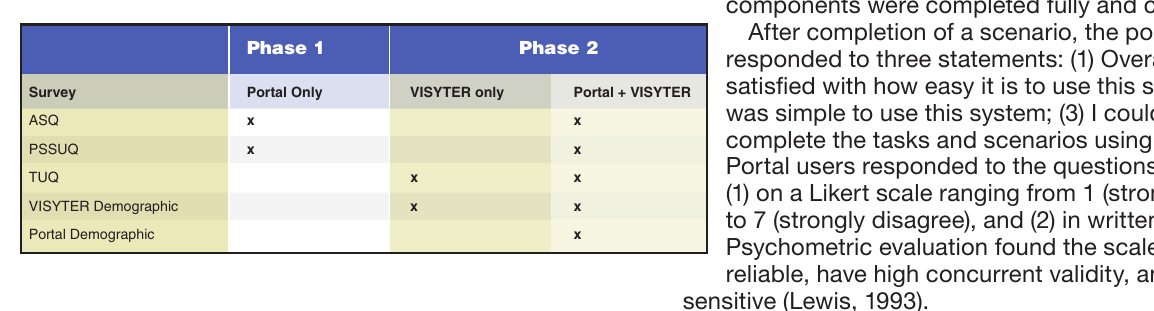
Table 1 Phase 1 and 2 Survey Completion across TR System User Groups